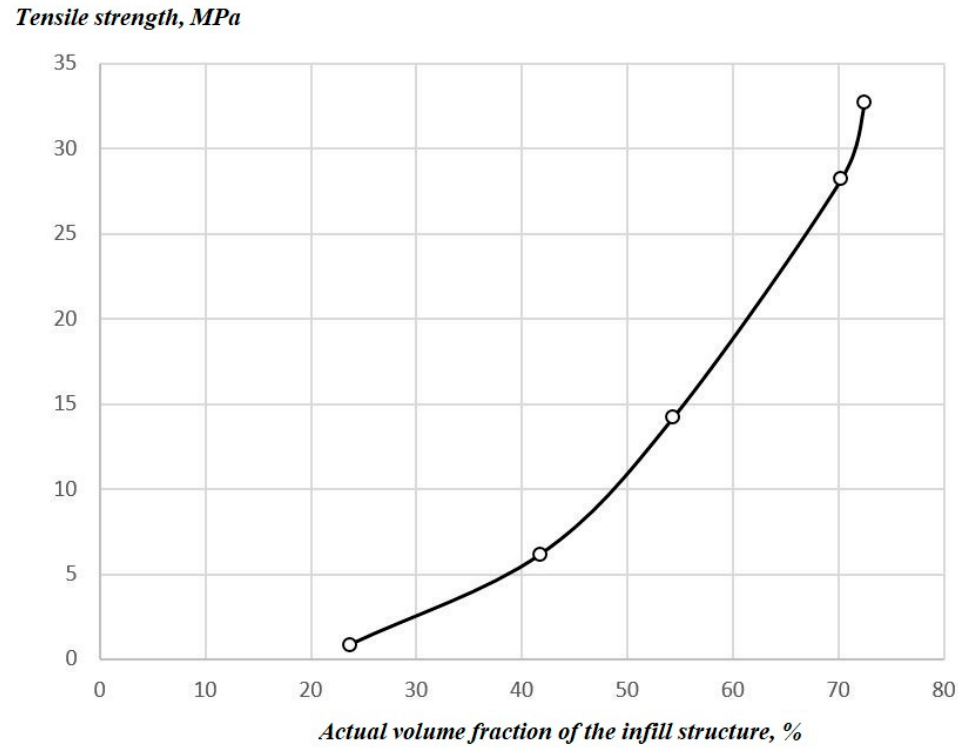
Figure 7. Dependence of the tensile strength on the actual volume fraction of the infill structure.